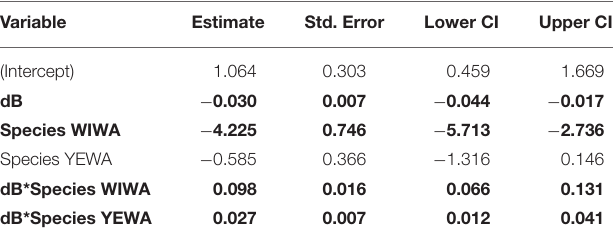
TABLE 4 | The output for a linear mixed effect model of the canopy gleaning guild. Variable